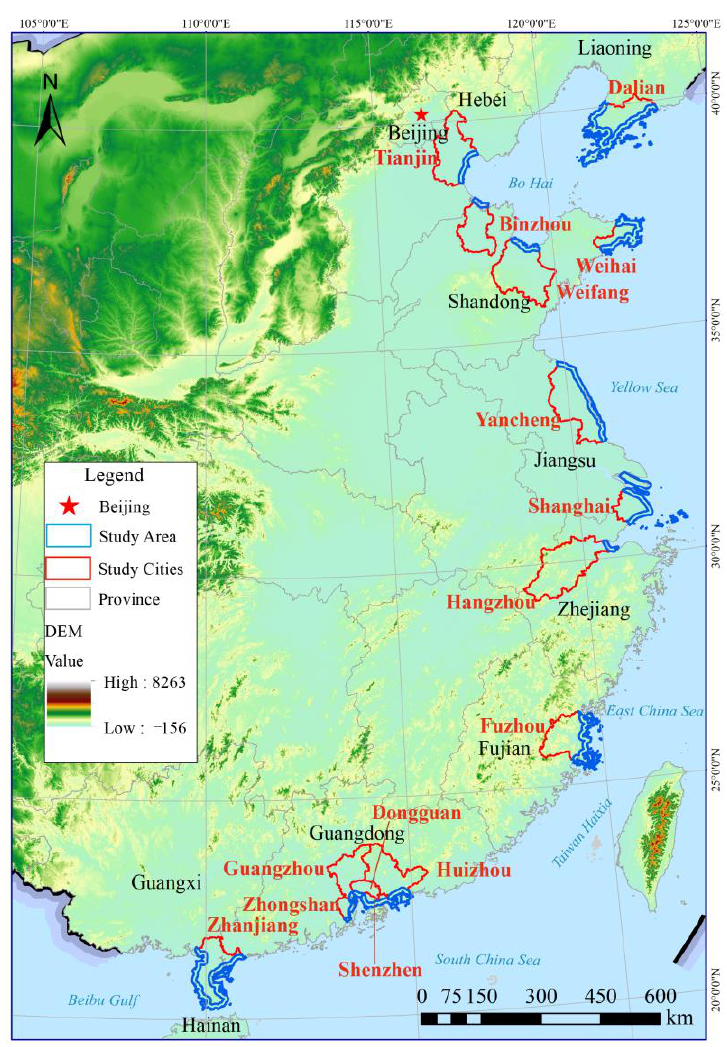
Figure 2. The geographical distribution of different types of coastal cities in China.